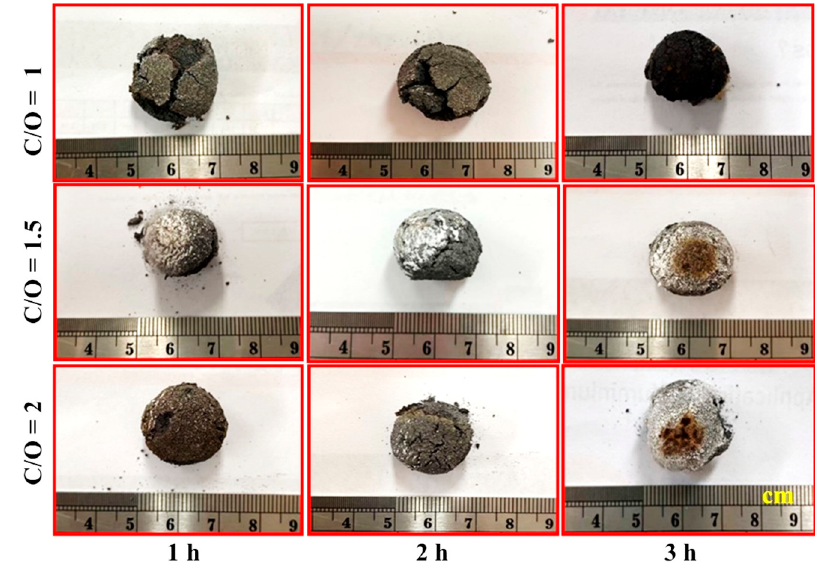
Figure 2. Pellet samples after heating at 1550 °C for up to 3 h.